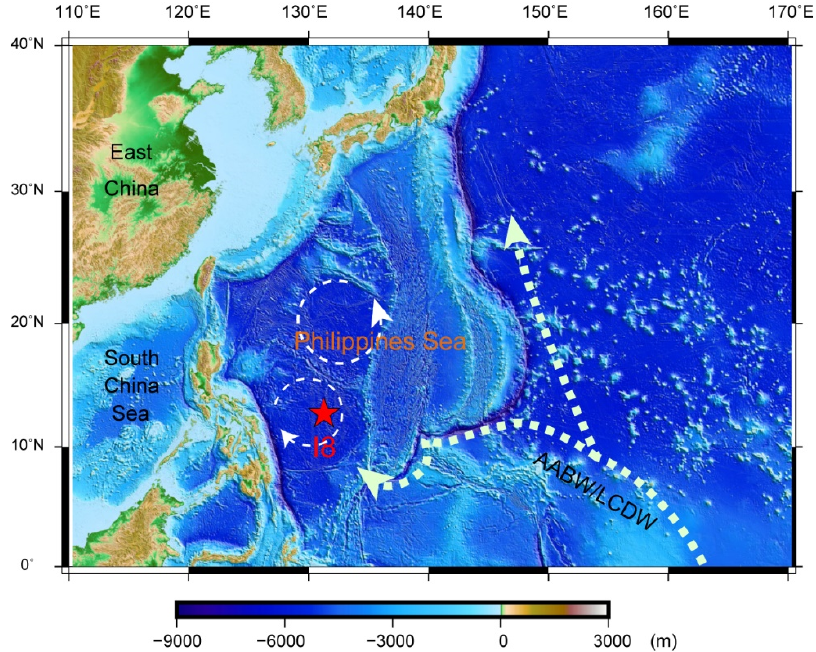
Figure 1. Schematic map showing the core location (red star) and oceanographic setting. AABW: Antarctic Bottom Water, LCDW: Lower Circumpolar Deep Water. The map was generated by using Generic Mapping Tools (GMT toolbox, http://gmt.soest.hawaii.edu/, 01 November 2022) in C programs [19,20].